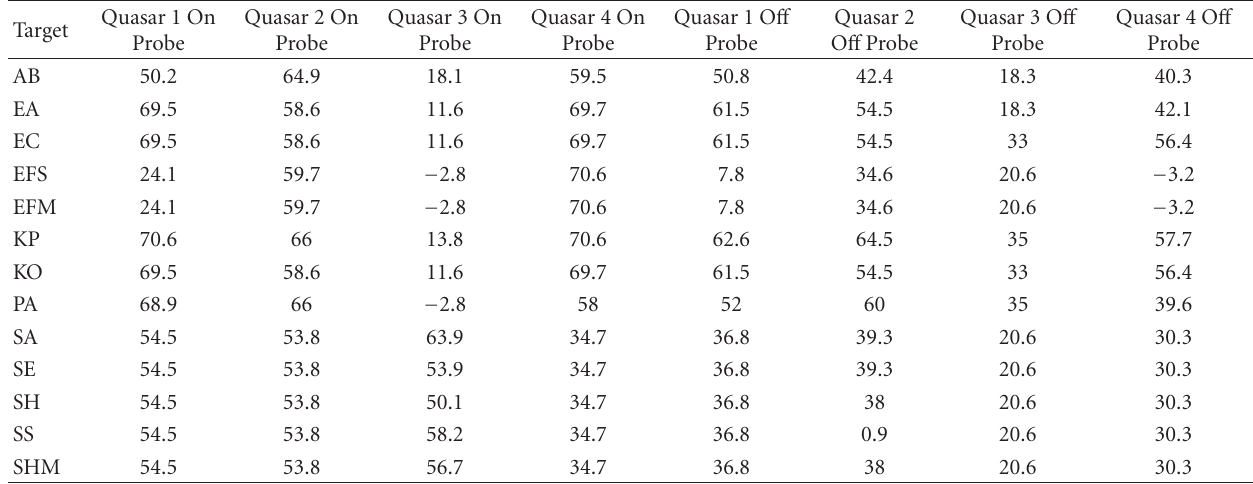
Table 2: 16S On/O ff Predicted Probe Tms ◦